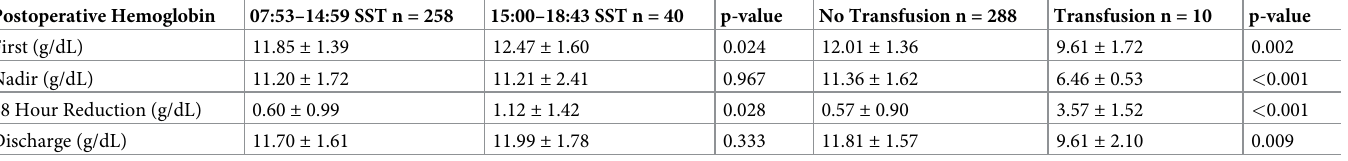
On ROC analysis, a 15:00–18:43 SST predicted postoperative blood transfusion with 40.0% sensitivity and 87.5% specificity. A repeated ROC analysis using various SST thresholds dem- onstrated that accuracy was improved to 70.0% sensitivity and 83.0% specificity at a time threshold of 14:34 (Fig 2). The c-statistic improved from 0.638 to 0.672 under the 14:34 threshold. Table 3. Post-hoc audit comparing postoperative hemoglobin by SST cohort and transfusion cohort. Postoperative